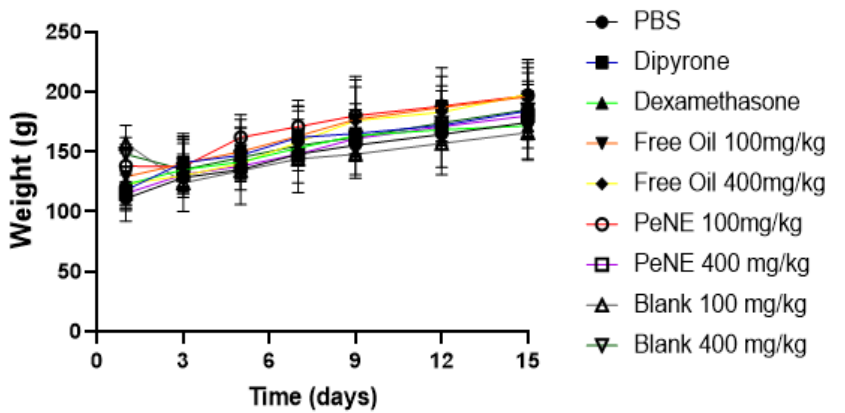
Figure 8. Weight of the animals during the 15 days of treatment with free oil (100 and 400 mg/kg/p.o.), nanoencapsulated pequi oil (PeNE 100 and 400 mg/kg/p.o.), blank, dipyrone (120 mg/kg/i.p.), dexamethasone (2 mg/kg/i.p.) and PBS, the negative control group.